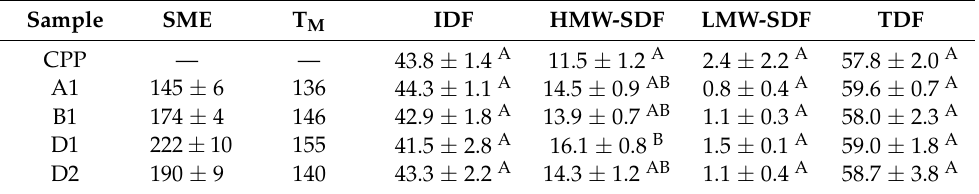
Table 2. Dietary fiber (DF) contents of chokeberry pomace powder (CPP) before and after extrusion processing (g/100 g dm, mean ± SD, n = 2) at water contents of 13% (A1, B1, and D1) and 23% (D2), respectively. SME, specific mechanical energy (Whkg − 1 ); T M , material temperature ( ◦ C); IDF, insoluble DF; HMW-SDF, high molecular weight soluble DF; LMW-SDF, low molecular